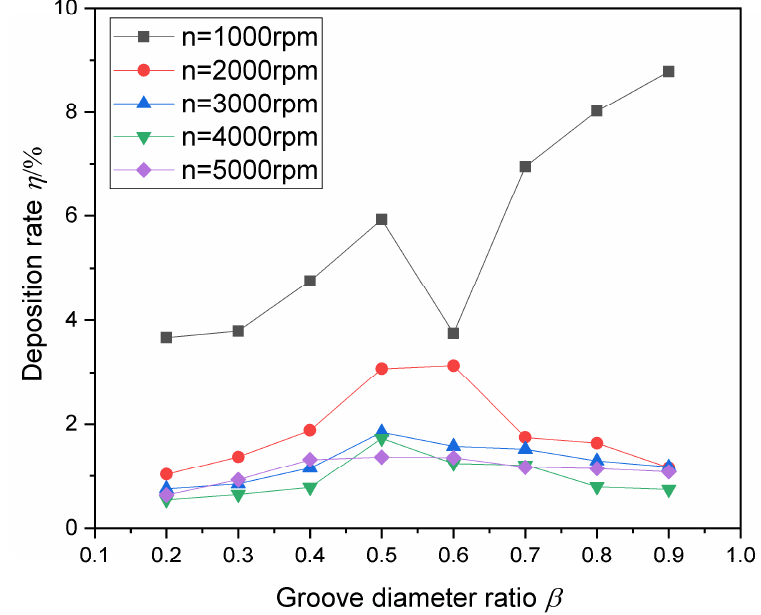
Figure 13. Influence of groove diameter ratio on the deposition rate.